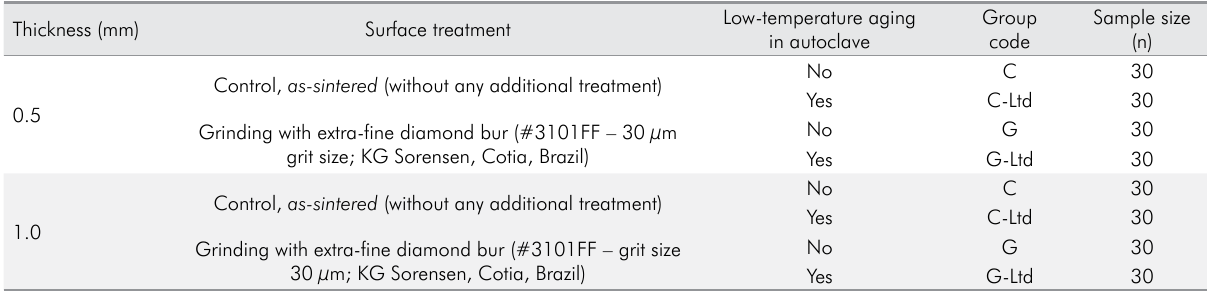
Table 1. Experimental